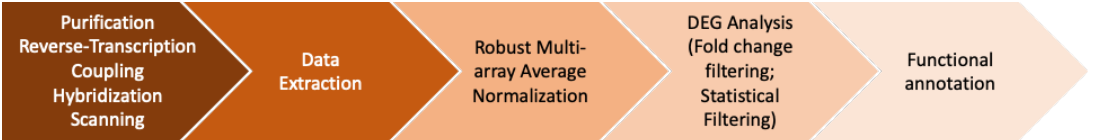
Figure 2. Workflow involved in cDNA microarray data analysis.